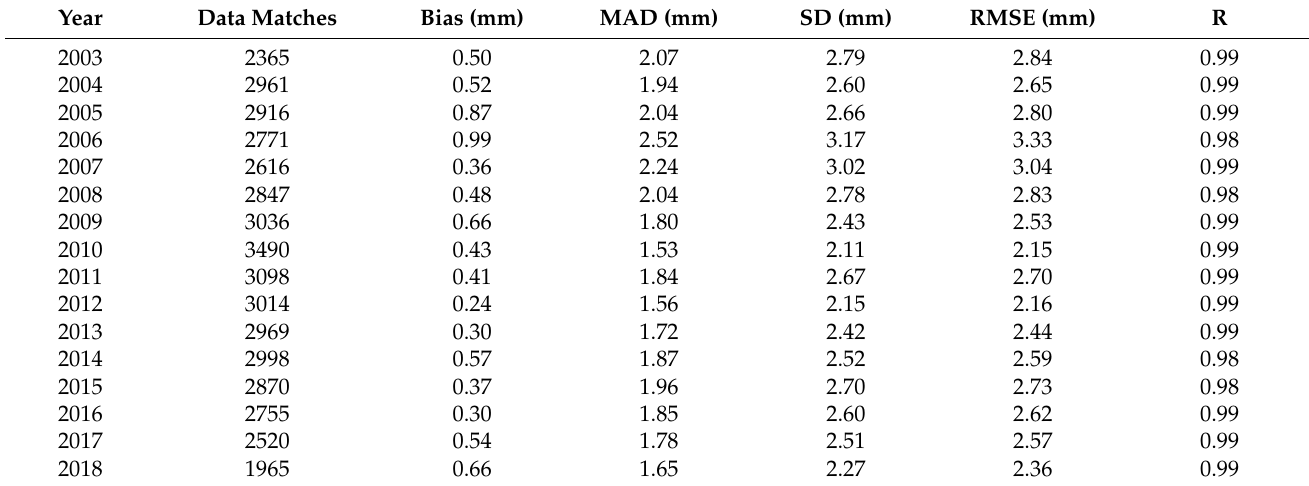
Table 2. Statistics on the precision of global ocean water vapor fusion products.